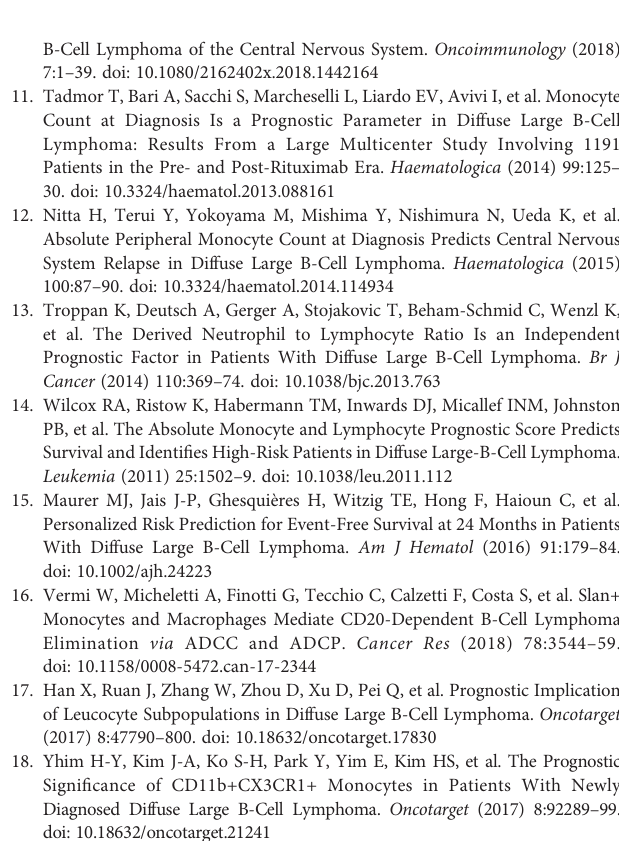
HD before analysis by high-throughput Q-PCR for genes listed in Table S3. Pearson's correlation and complete linkage were employed. Figure S4 | Q-PCR analysis, unsupervised hierarchical clustering for ncMO Slanpos and ncMO Slanneg from DLBCL and HD patients ncMO Slanpos and ncMO Slanneg were sorted from 7 DLBCL and 4 HD before analysis by high- throughput Q-PCRfor geneslisted in TableS3. Pearson's correlation and complete linkage were employed. Figure S5 | Q-PCRanalysis,unsupervisedhierarchicalclusteringforcMO,iMO,ncMO SlanposandncMOSlannegfromDLBCLpatientscMO,iMO,ncMOSlanpos,andncMO Slannegweresortedfrom7DLBCLbeforeanalysisbyhigh-throughputQ-PCRforgenes listedinTableS3. Pearson'scorrelationandcompletelinkagewereemployed. Figure S6 | Q-PCR analysis, unsupervised hierarchical clustering for cMO, iMO, ncMO Slanpos and ncMO Slanneg from DLBCL and HD patients cMO, iMO, ncMO Slanpos, and ncMO Slanneg were sorted from 7 DLBCL and 4 HD before analysis by high-throughput Q-PCR for genes listed in Table S3. Pearson's correlation and complete linkage were employed. Figure S7 | High levels of circulating ncMO is an adverse event in DLBCL.Event- freesurvival(EFS)intrainingcohorts(NCT01287923)ThresholdoftheratioofncMO to other monocytes parameter was de fi ned onthe training cohort using the maxstat package. Table S1 | Antibodies for fl uorescent fl ow cytometry analysis. Table S2 | Antibodies or parameters used for mass cytometry analysis. Table S3 | Listofgenesevaluatedbyhigh-throughputQ-PCRonmonocytesubsets. Table S4 | QPCR